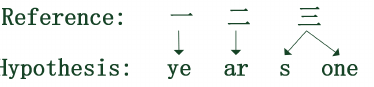
Figure 5. An example of units in one language being incorrectly identified as units in another lan-